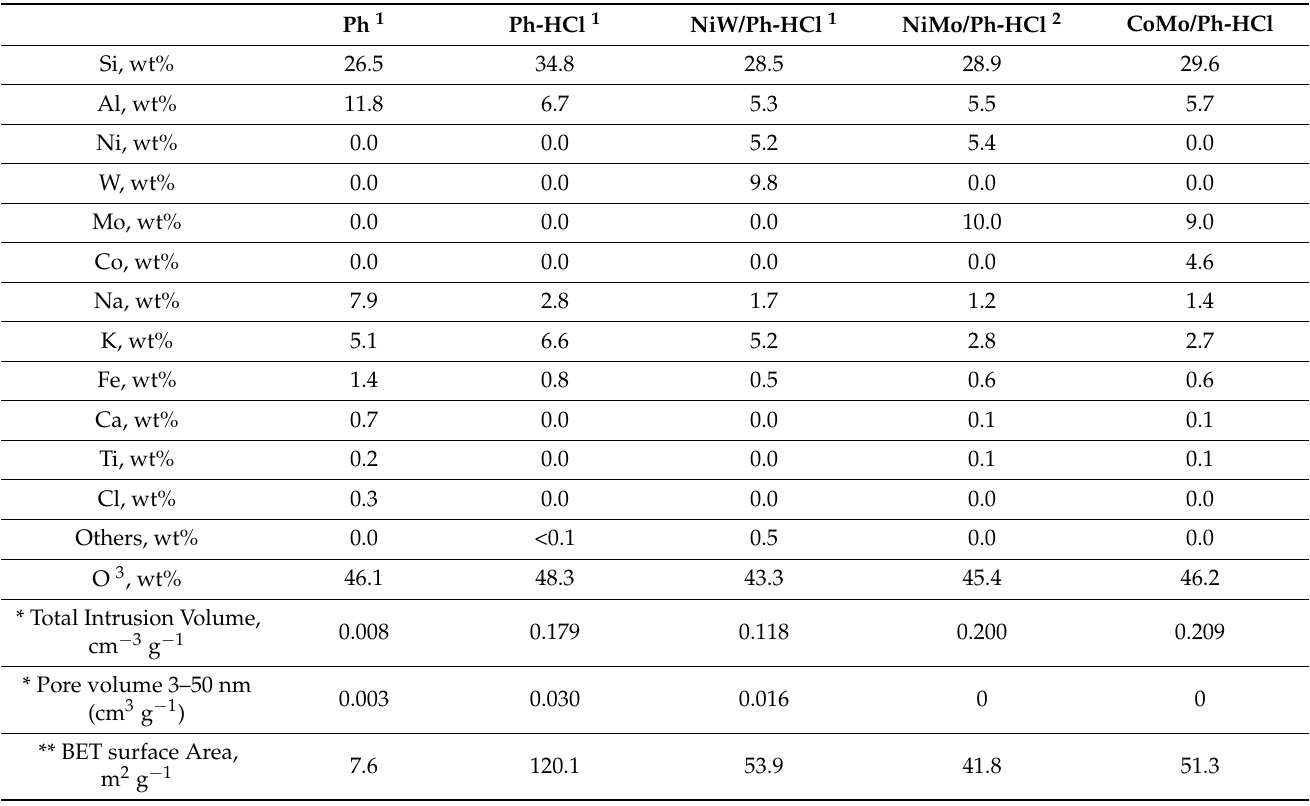
Table 1. X-ray fluorescence (XRF) elemental analysis for the supports, original Ph material, and catalysts. Textural properties of the original Ph material and its derived